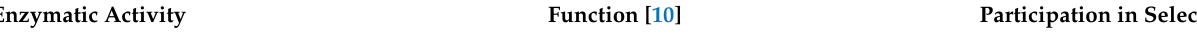
Table 2. Cont. Table 2. Participation of SIRTs in selected pathological disorders. Table 2. Participation of SIRTs in selected pathological disorders. Table 2. Participation of SIRTs in selected pathological disorders. Table 2. Participation of SIRTs in selected pathological disorders. Table 2. Participation of SIRTs in selected pathological disorders. Table 2. Participation of SIRTs in selected pathological disorders. Table 2. Participation of SIRTs in selected pathological disorders. Table 2. Participation of SIRTs in selected pathological disorders. Table 2. Participation of SIRTs in selected pathological disorders. Table 2. Participation of SIRTs in selected pathological disorders. Table 2. Participation of SIRTs in selected pathological disorders. Table 2. Participation of SIRTs in selected pathological disorders. Table 2. Participation of SIRTs in selected pathological disorders. Table 2. Participation of SIRTs in selected pathological disorders. Table 2. Participation of SIRTs in selected pathological disorders. Table 2. Participation of SIRTs in selected pathological disorders. Table 2. Participation of SIRTs in selected pathological disorders. Table 2. Participation of SIRTs in selected pathological disorders. Table 2. Participation of SIRTs in selected pathological disorders. Table 2. Participation of SIRTs in selected pathological disorders. Table 2. Participation of SIRTs in selected pathological disorders. Table 2. Participation of SIRTs in selected pathological disorders. Table 2. Participation of SIRTs in selected pathological disorders. Table 2. Participation of SIRTs in selected pathological disorders. Table 2. Participation of SIRTs in selected pathological